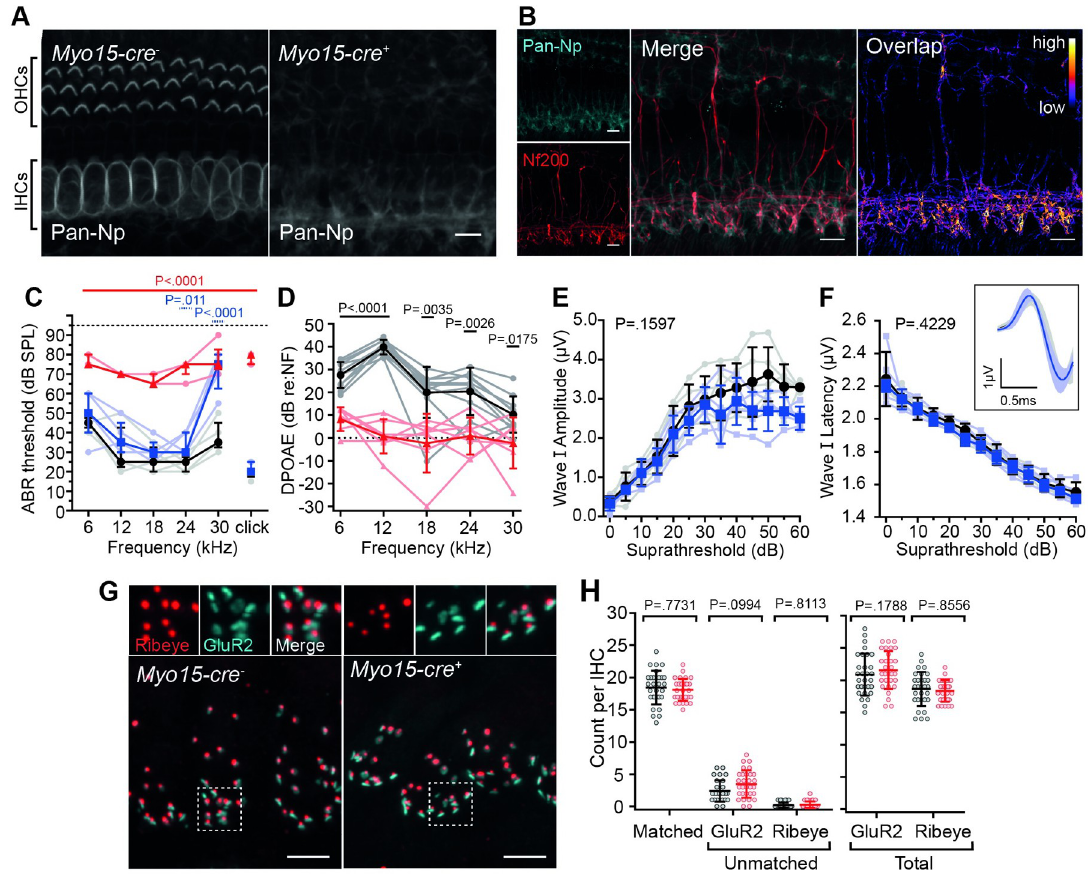
Fig 7. Hair Cell-specific deletion of Neuroplastin elicits a milder auditory phenotype. (A) Maximum intensity projections of whole- mount mid-apical cochleae from 1-month old mice labelled with an anti-pan-Np antibody. Neuroplastin is specifically deleted from both IHCs and OHCs in Myo15-cre + cochleae. Staining for Neuroplastin is still present around the base of IHCs. Scale bar = 10 μ m. (B) Co-labelling with anti-Neurofilament 200K (NF200) in Nptn fl/fl ;Myo15-cre + cochleae. Overlap (right) shows regions in which signals for both Neuroplastin and NF200 are detected, with colour indicating summed intensity of signal. Patterns of staining are similar for both antibodies at the base of IHCs suggesting that Neuroplastin labelling is associated with spiral ganglion fibres. Scale bar = 10 μ m. (C) ABR threshold measures for Myo15-cre + mice at 1-month of age shows elevated thresholds in Nptn fl/fl ;Myo15-cre + mice (red triangles, n = 5) compared to Nptn +/+ ;Myo15-cre + mice (black circles, n = 5). Heterozygous Nptn +/fl ;Myo15-cre + mice (blue squares, n = 5) also exhibit raised thresholds at � 24 kHz compared with controls. Data are median ± IQR with individual data points shown. One-way ANOVA comparing against wild type using Dunnett’s test for multiple comparisons. (D) Average DPOAE responses of Nptn fl/fl ;Myo15-cre - (black circles, n = 10) and Nptn fl/fl ;Myo15-cre + (red triangles, n = 7) mice at 1-month of age. Data are mean ± SD with individual data points shown. One-way ANOVA comparing against wild type controls using Dunnett’s test for multiple comparisons. (E-F) Click-evoked ABR wave I measures comparing Nptn +/fl ;Myo15-cre + with Nptn +/+ ;Myo15-cre + mice. Waveforms were not significantly different. Amplitude: P = 0.1597, Latency: P = 0.4229 (two-way ANOVA). Inset shows an average of wave I following click stimulus at 30 dB above threshold. Data are mean ± SD with individual data points shown. (G) Maximum intensity projections of mid-apical cochlear whole-mounts from Nptn fl/fl ;Myo15-cre - and Nptn fl/fl ;Myo15-cre + mice labelled with the IHC pre-synaptic ribbon marker Ribeye (red) and post-synaptic density marker GluR2/3 (cyan). Insets show an enlarged 5 μ m x 5 μ m region highlighted by the dashed box in the above image. Scale bar = 5 μ m. (H) Counts of Ribeye and GluR2/3 puncta were made from ten adjacent hair cells (two independent regions per mouse, three mice per genotype). Ribeye and GluR2/3 were considered matched when directly juxtaposed to one and other. No significant difference was found in the total numbers of Ribeye or GluR2 puncta, or matched Ribeye/GluR2 puncta. Data are mean ± SD with individual data points shown. Data compared against wild type controls using unpaired t-tests with a Holm-Sidak correction for multiple